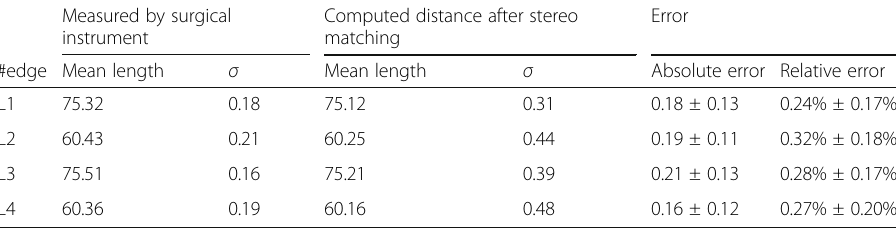
Table 1 Length of four board ’ s edges measured by EM sensor model 90 and Vernier caliper in mm Measured by surgical Computed distance after stereo instrument matching